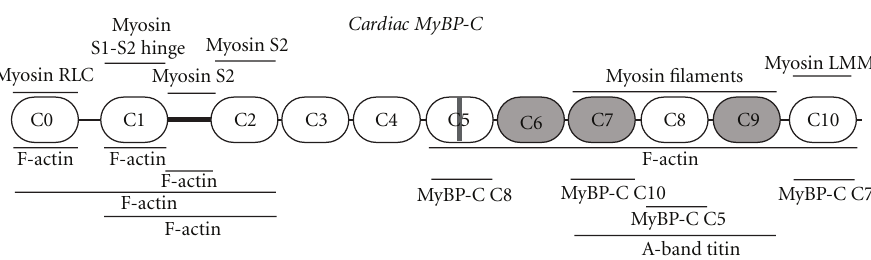
Figure 2: Schematic representation of cardiac MyBP-C, illustrating its domain architecture and known binding partners. Immunoglobulin and fibronectin type III domains are shown as white and grey ovals, respectively. The M-motif is denoted as a dark black line flanked by domains C1 and C2. The cardiac specific insertion within domain C5 is shown as a grey rectangle. Ligands for cMyBP-C are indicated at their sites of